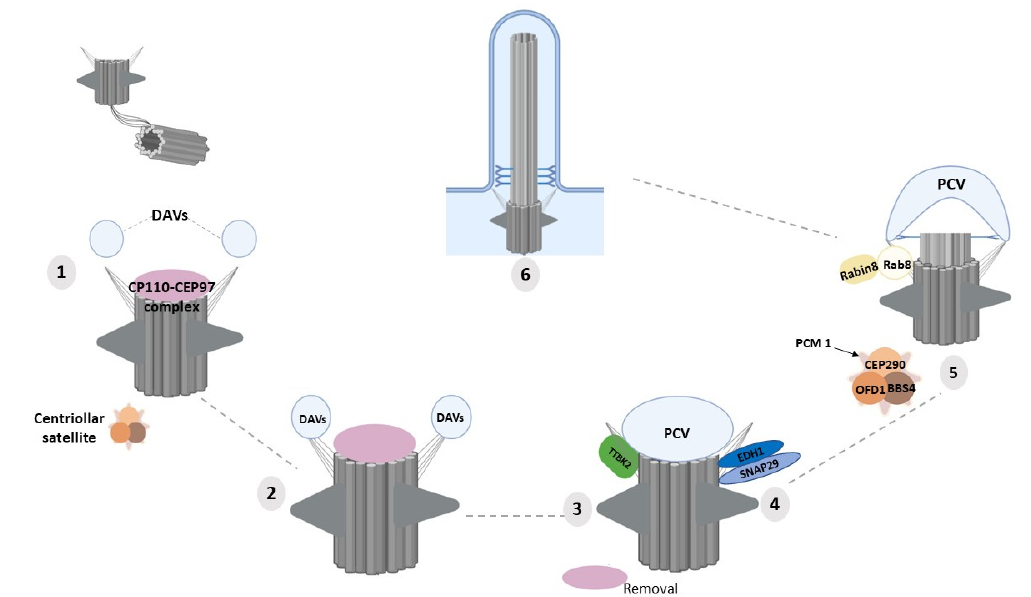
Figure 3. The main steps of primary ciliary vesicle docking to DAPs during ciliogenesis. ( 1 ) After the conversion of the mother centriole into the basal body, the CP110–CEP97 protein complex caps the basal body and hinders ciliogenesis initiation. ( 2 ) Docking of small ciliary vesicles to DAPs leads to the formation of distal appendage vesicles (DAVs). ( 3 ) Larger primary ciliary vesicles (PCVs) form from smaller DAVs (facilitated by EDH1 and SNAP29 proteins). ( 4 ) Recruitment of TTBK2 and removal of the inhibitory CP110–CEP97 complex. ( 5 ) Rab8-positive vesicle docks at the centrosome, membranes are extended, and the axoneme is elongated, leading to ( 6 ) the completion of cilium formation. Image was created by BioRender.